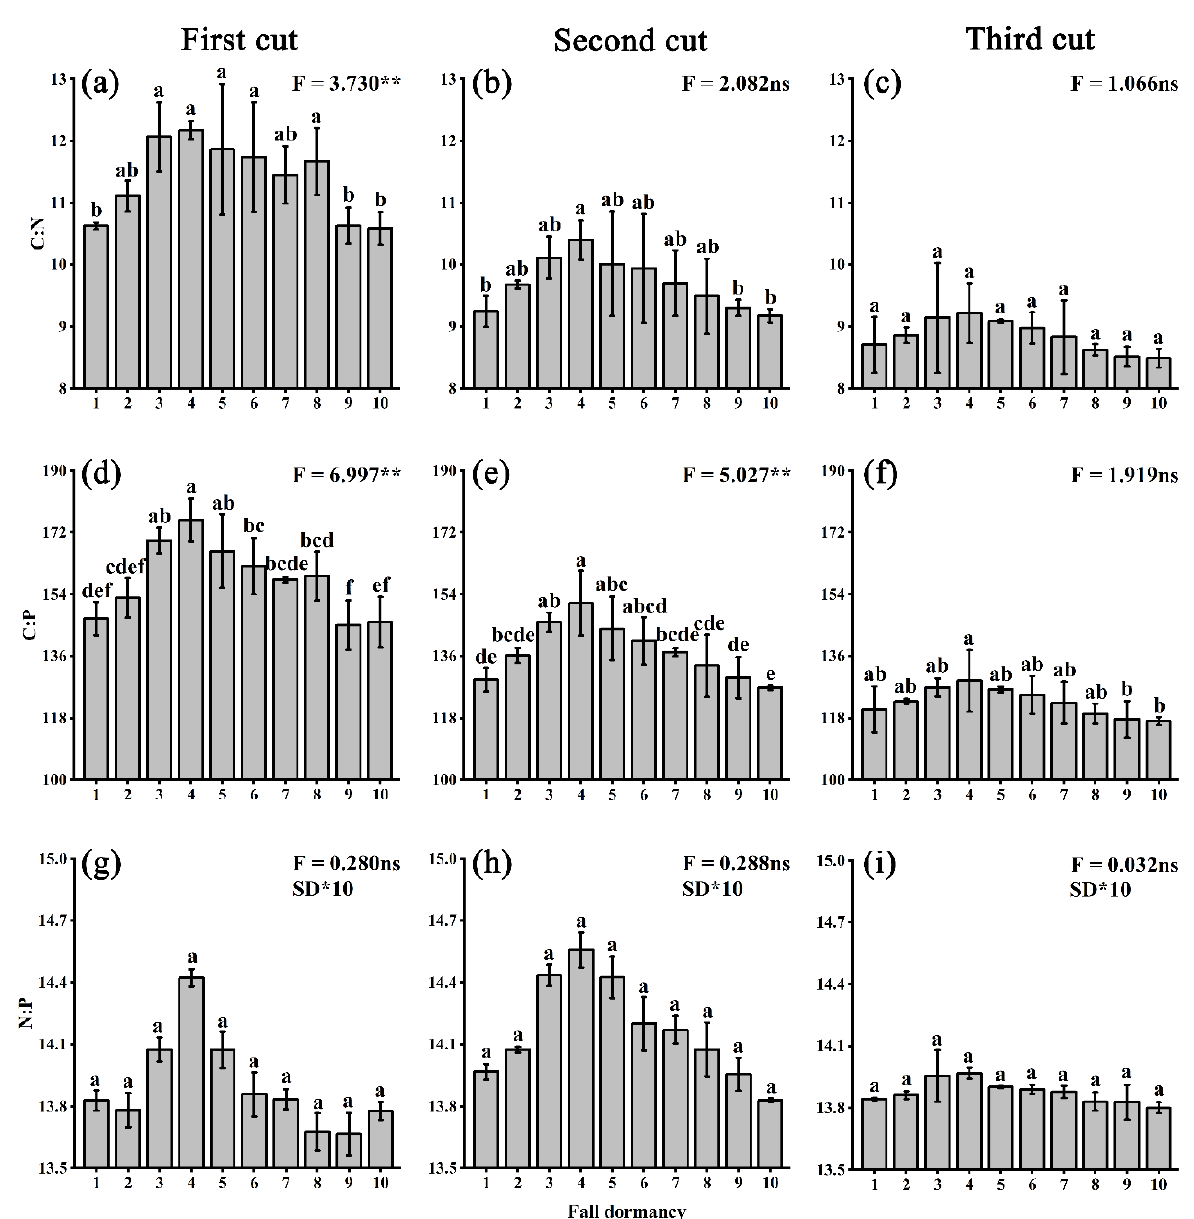
Figure 3. Stoichiometric ratios of elements in mature alfalfa leaves with different fall-dormancy levels in 2020. ( a , d , g ) are the first cut; ( b , e , h ) are the second cut; ( c , f , i ) are the third cut. SD*10 means that the standard error should be multiplied by 10. Different small letters indicate significant differences between different fall dormancy levels ( p < 0.05). ns indicates no significant difference between different fall dormancy levels ( p > 0.05), * indicates significant difference between different fall dormancy levels ( p < 0.05) and ** indicates extremely significant difference between different fall dormancy levels ( p < 0.01).